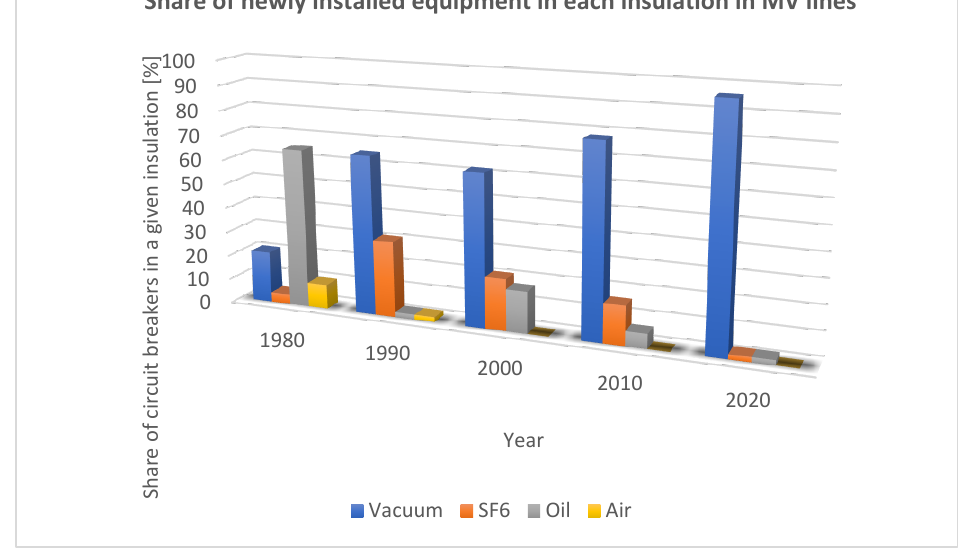
Figure 1. Proportion of each type of equipment in the total number of installed apparatuses [7]. As can be seen from the diagram above, oil, air, sulfur hexafluoride (SF 6 ) and vacuum have played the role of insulating medium in switchgear over more than four decades [8].